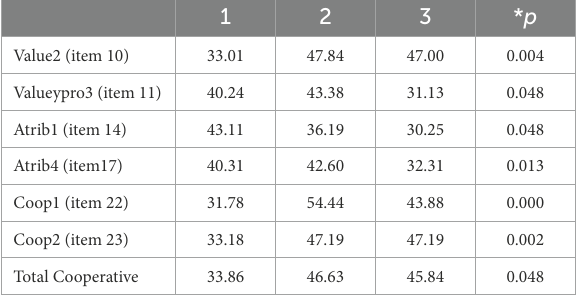
TABLE 10 Kruskal–Wallis analysis to evaluate how motivation depends on the teaching methodology